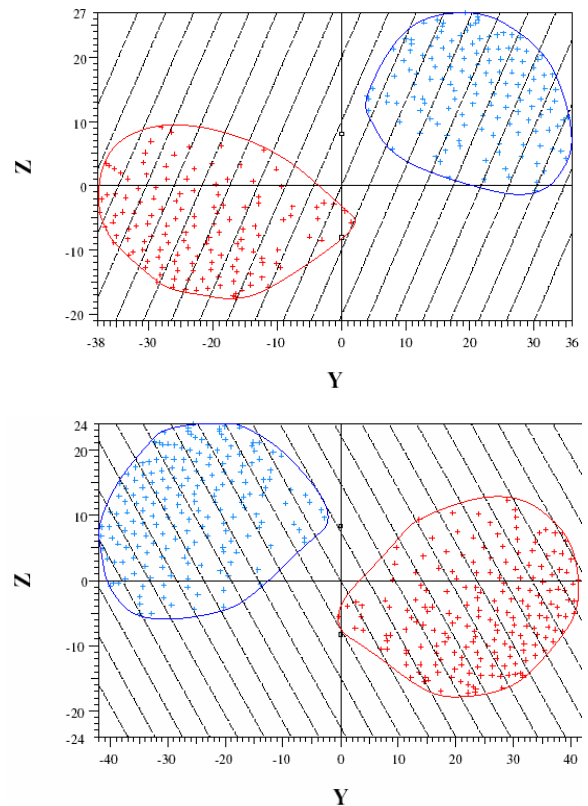
Figure 7. View from the Sun towards the Earth’s magnetosphere. The electric equipotentials are Fig. 7. View from the Sun towards the Earth’s magnetosphere. The shown by the dashed lines on the magnetopause. The intervals between the two inclined lines are electric equipotentials are shown by the dashed lines on the mag- equal to 4 R E and the potential drop between these two lines is equal to 16 kV. The region netopause. The intervals between the two inclined lines are equal bounded by the red (blue) curve shows the intersection of the southern/dawn (northern/dusk) to 4 R E and the potential drop between these two lines is equal to magnetopause with the open field line bundle of the northern (southern) polar cap. The parts of 16kV. The region bounded by the red (blue) curve shows the inter- the equipotential lines on the magnetopause which are placed inside these regions project to convection cells in the ionosphere. Upper panel : Case 1 . All calculations were made for the case section of the southern/dawn (northern/dusk) magnetopause with 1: UT 13 h 18 m Nov 8, 1998, when, according to the shifted ACE data, the IMF components were the open field line bundle of the northern (southern) polar cap. Bx =-10 nT, By =10 nT, and Bz =23 nT. The solar wind plasma parameters used in the model The parts of the equipotential lines on the magnetopause which calculations are: density 21 cm -3 and velocity 572 km/s. Bottom panel : Case 2. All calculations are placed inside these regions project to convection cells in the are made for case 2: UT 15 h Nov 8, 1998, when the IMF components, according to the shifted ionosphere. Upper panel: Case 1. All calculations were made ACE data were Bx = -8.2 nT, By =-14 nT, Bz =22 nT. The solar wind plasma parameters, which for the case 1: 13:18 UT on 8 November 1998, when, according were used in the model calculations, are: the density 15 cm -3 , and velocity 519 km/s for this case. to the shifted ACE data, the IMF components were B x = − 10nT, B y =10nT, and B z =23nT. The solar wind plasma parameters used in the model calculations are: density 21cm − 3 and velocity 572km/s. Bottom panel: Case 2. All calculations are made for case 2: 15:00 UT on 8 November 1998, when the IMF components, ac- cording to the shifted ACE data, were B x = − 8.2nT, B y = − 14nT, B z =22nT. The solar wind plasma parameters which were used in the model calculations are: the density 15cm − 3 , and velocity 519km/s for this